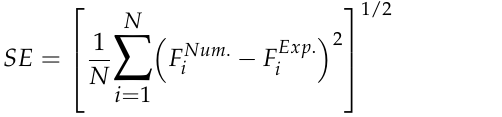
Figure 20. Influence of the mesh size on the load–elongation curve.